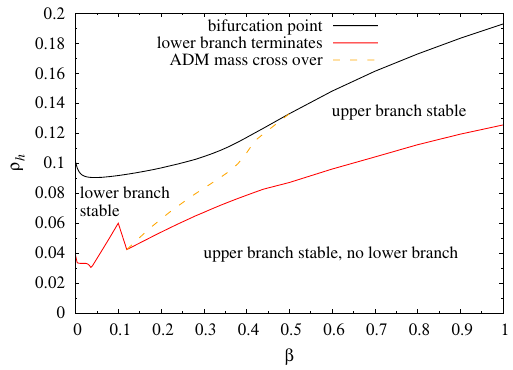
Figure 16 . Phase diagram for the 2 + 4 + 12 model based on the lowest ADM